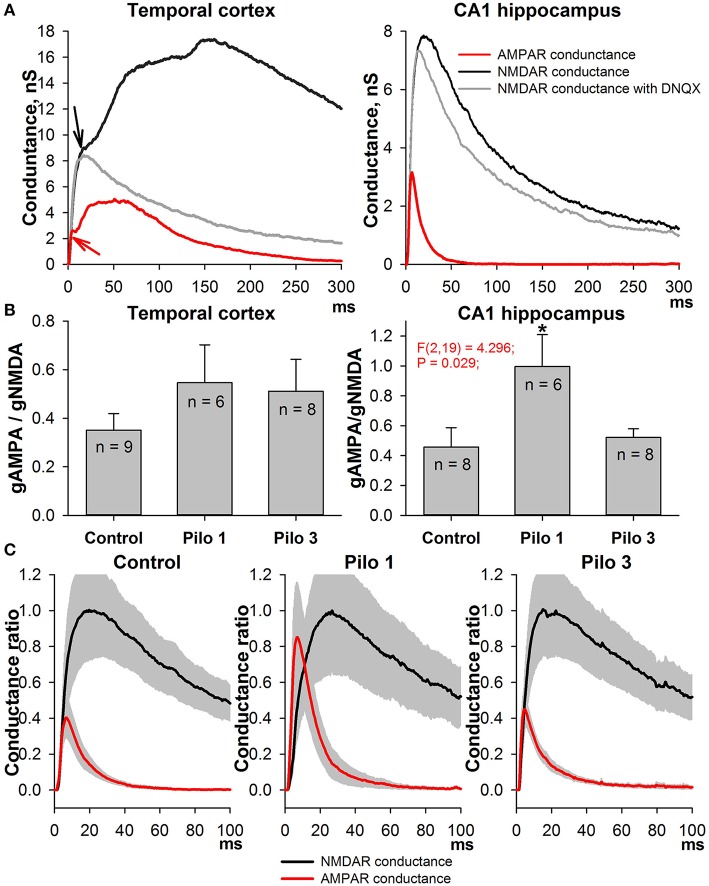
Changes in AMPAR/NMDAR conductance ratios in PILO-rats. (A) The estimated conductances as functions of time for TC neurons (left, an average of 9 cells) and CA1 neurons (right, an average of 8 cells). Arrows on the right plot indicate the monosynaptic peaks of AMPAR- and NMDAR-mediated conductances, which were used to assess the ratios on (B). The red line represents the time course of AMPAR conductance; the black line is calculated NMDAR conductance during the evoked EPSCs; and the gray line—NMDAR conductance after the block of AMPARs. (B) Peak AMPAR/NMDAR conductance ratios for TC (left) and CA1 neurons of control (Control) and PILO-rats sacrificed at the following time intervals after PILO administration: Pilo 1 – 24 h, Pilo 3 – 3 days. An asterisk (*) indicates significant difference (p < 0.05) with the control group (Dunnett's post hoc test, multiple comparisons vs. control group). (C) The time course of AMPAR- and NMDAR-mediated conductances during the evoked response in the hippocampal pyramidal neurons in control and PILO-rats. A gray area shows the standard error.